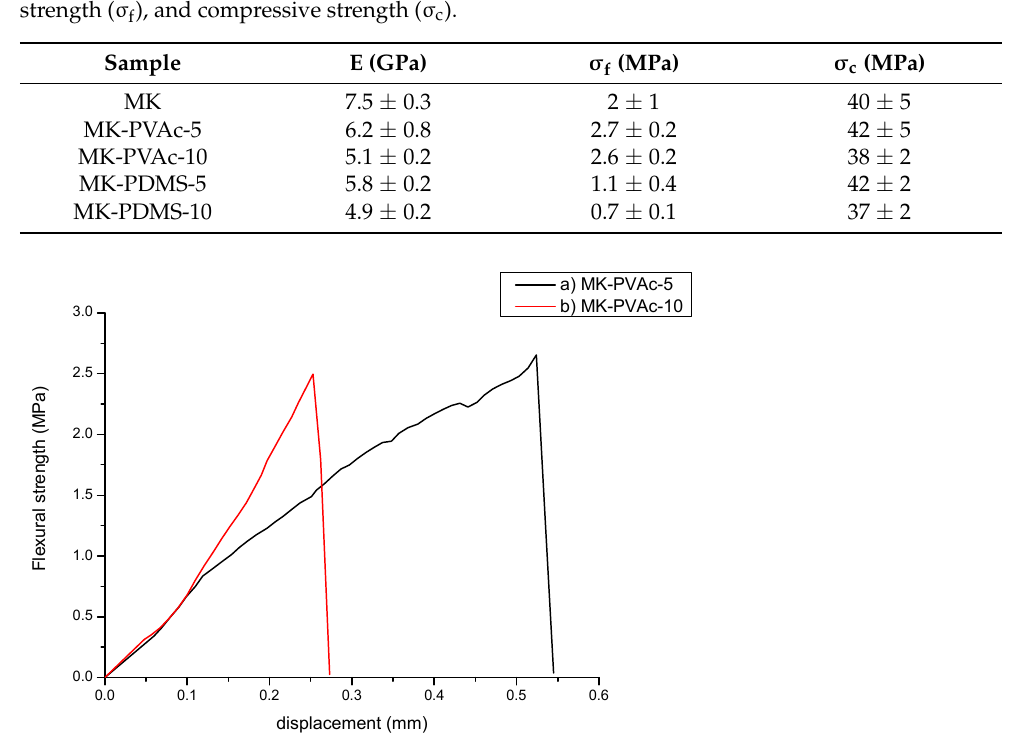
Figure 5. Flexural strength vs. displacement for relevant samples: ( a ) MK-PVAc-5; ( b ) MK- PVAc- 10.